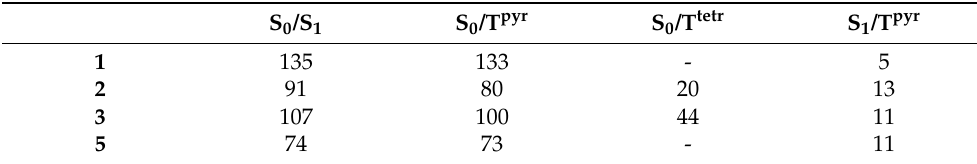
Figure 7. Representations of the tetrahedral ground state ( a ), tetrahedral triplet ( b ), and pyramidal triplet ( c ) for 3 . All atoms except N, P, and F coordinated to copper are shown as a wireframe. Cu–F distances are shown in Å, angles are summarized in Table S2. Table 5. Geometry differences between different electronic states as a sum of copper angle differences (modulo).